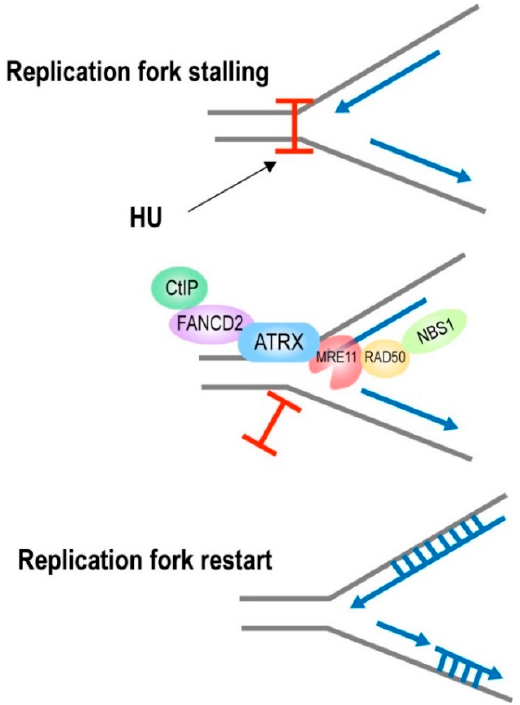
Figure 3. ATRX cooperated with FANCD2 and MRE11 to respond to the HU-induced replication stress and promote replication restart. Abbreviations: MRE11, meiotic recombination 11; HU, hy-